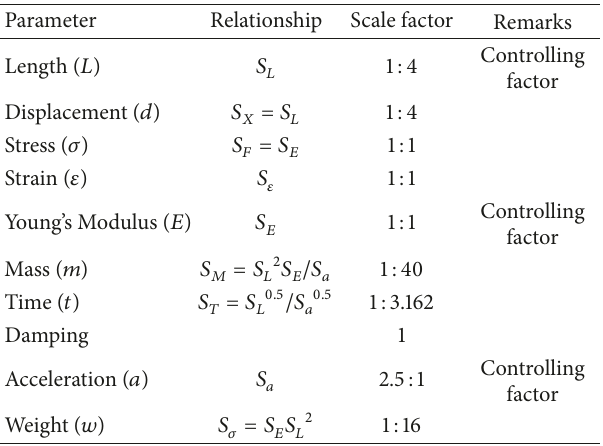
Table 1: Scale factors adopted in this